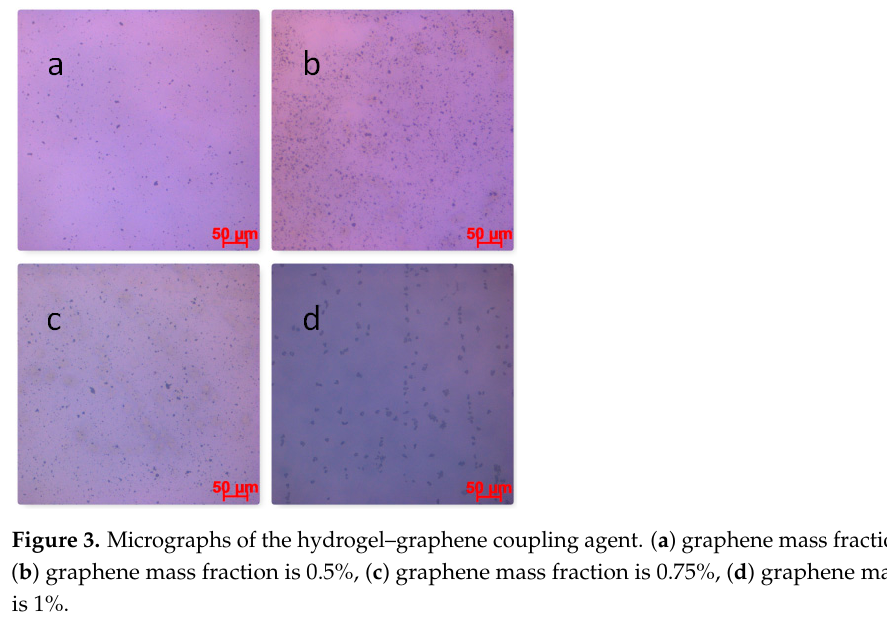
Table 1. Graphene agglomerated particle diameter in micrograph of a hydrogel–graphene coupling agent.